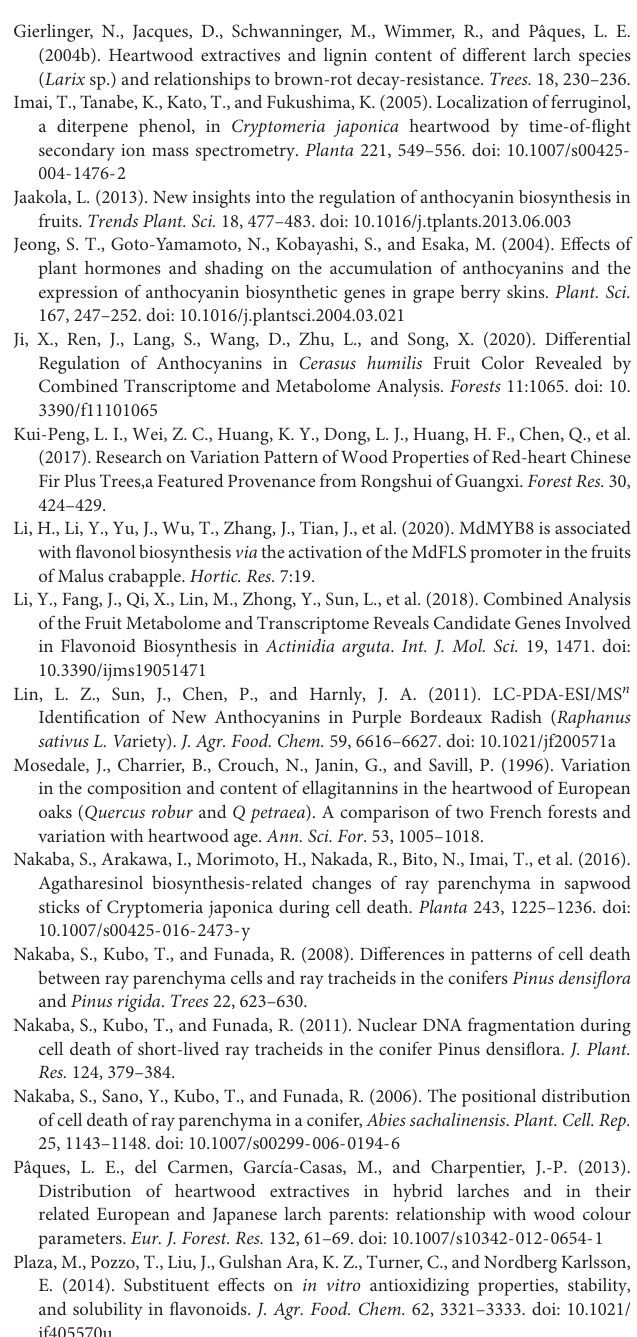
white-heart and red-heart Chinese fir. (A) Differences in pathway of WH-SW vs. RH-SW. (B) Differences in pathway of WH-TZ vs. RH-TZ. (C) Differences in pathway of WH-OHW vs. RH-OHW. (D) Differences in pathway of WH-IHW vs. RH-IHW. Supplementary Figure 2 | Gene Ontology (GO) function annotation diagram. Supplementary Figure 3 | Clusters of orthologous groups (COGs) diagram. Supplementary Figure 4 | Kyoto Encyclopedia of Genes and Genomes (KEGG) diagram.